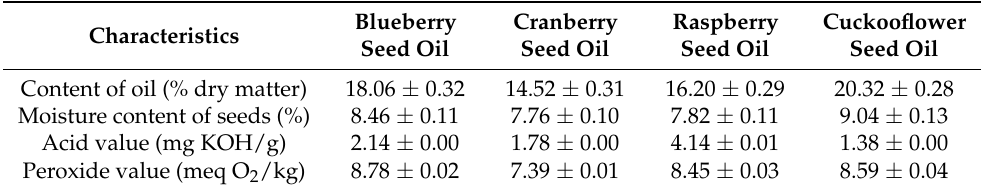
Table 1. Physicochemical properties of blueberry, cranberry, raspberry, cuckooflower seed oils obtained by sonification.